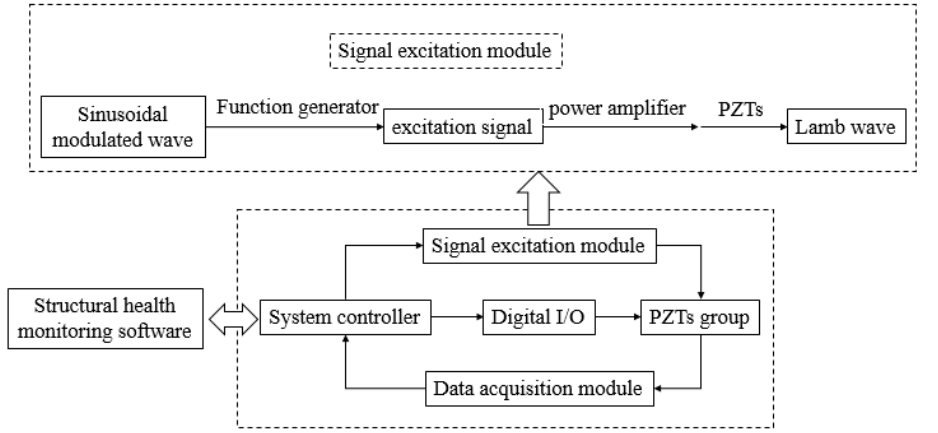
Figure 5. Schematic diagram of the piezoelectric sensor debonding monitoring system. I/O = Input/Output.